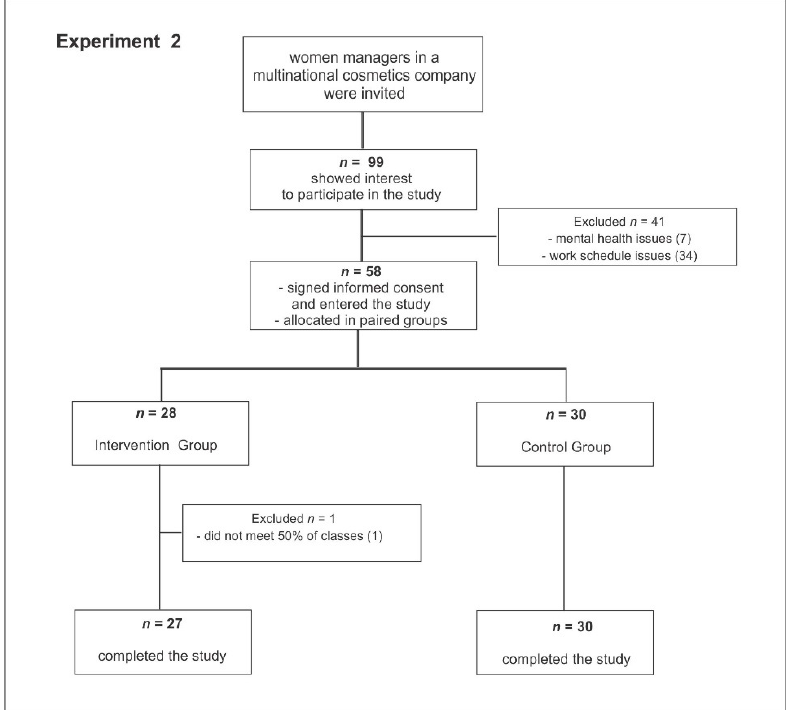
Figure 2. Consort flow chart (Experiment 2).